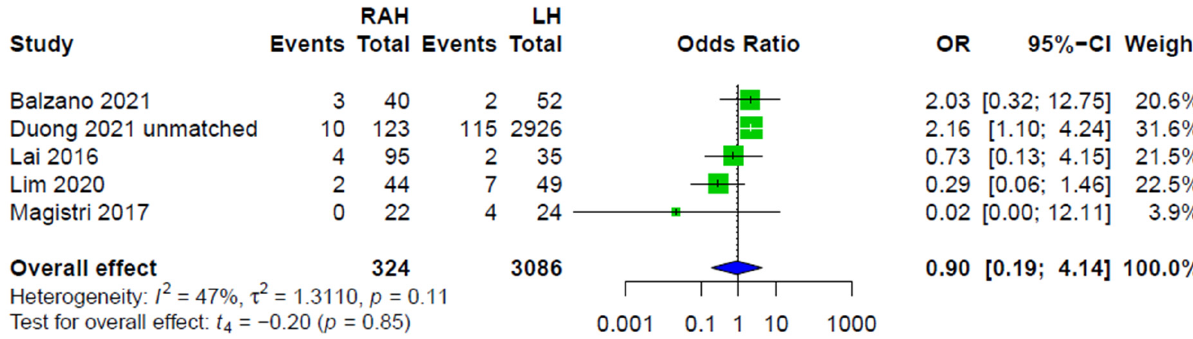
Figure 6. Forest plot for conversion rates during LH and RAH.